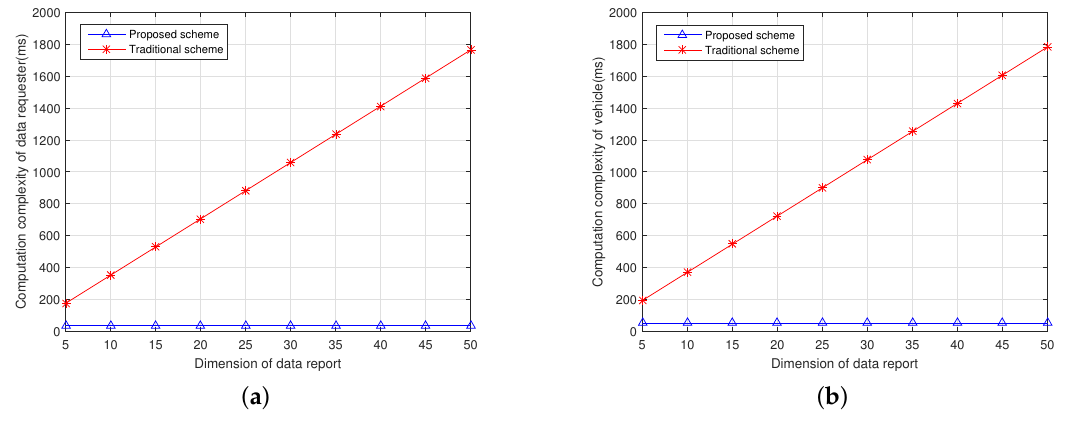
Figure 5. Comparison of the computation complexity of the data requester and vehicle. ( a ) Computation complexity of the data requester; ( b ) Computation complexity of one data uploading vehicle.